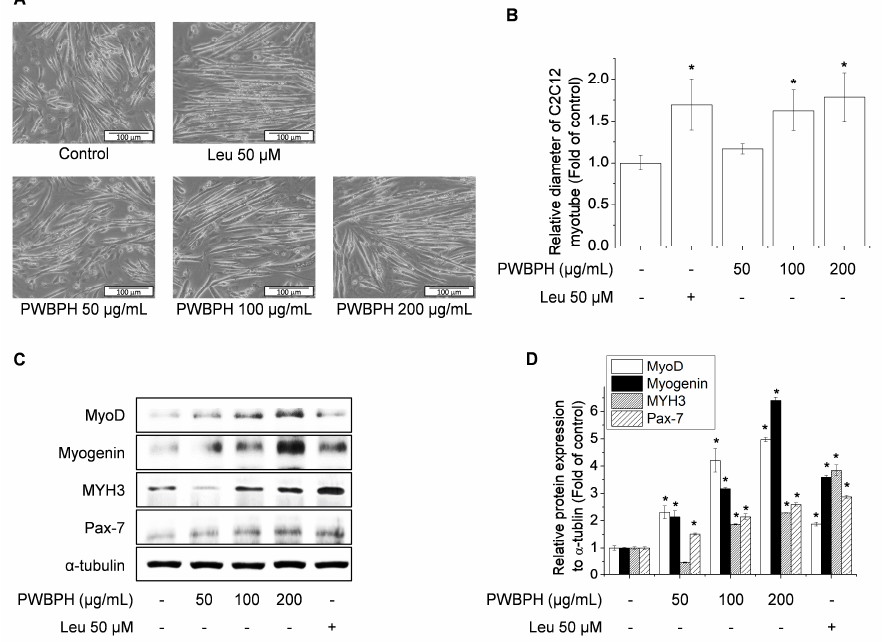
Figure 3. Effects of PWBPH treatment on differentiation and hypertrophy of C2C12 cells. C2C12 cells were treated with DM alone, or DM supplemented with PWBPH (50–200 µ g/mL), or Leu (50 µ M) for 4 days, and were then photographed under a phase-contrast microscope (10 × magnification). ( A ) Images are representative of 3 independent experiments (scale bar, 100 µ m). ( B ) Myotube diameter was calculated as the average diameter of myotubes using Image J software. ( C ) The levels of muscle differentiation proteins (MyoD, myogenin, MYH3, and Pax7) were determined by Western blotting. ( D ) The band intensities were measured using Image J software. Data are shown as the means ± SD from three independent experiments. * p < 0.05 vs. control